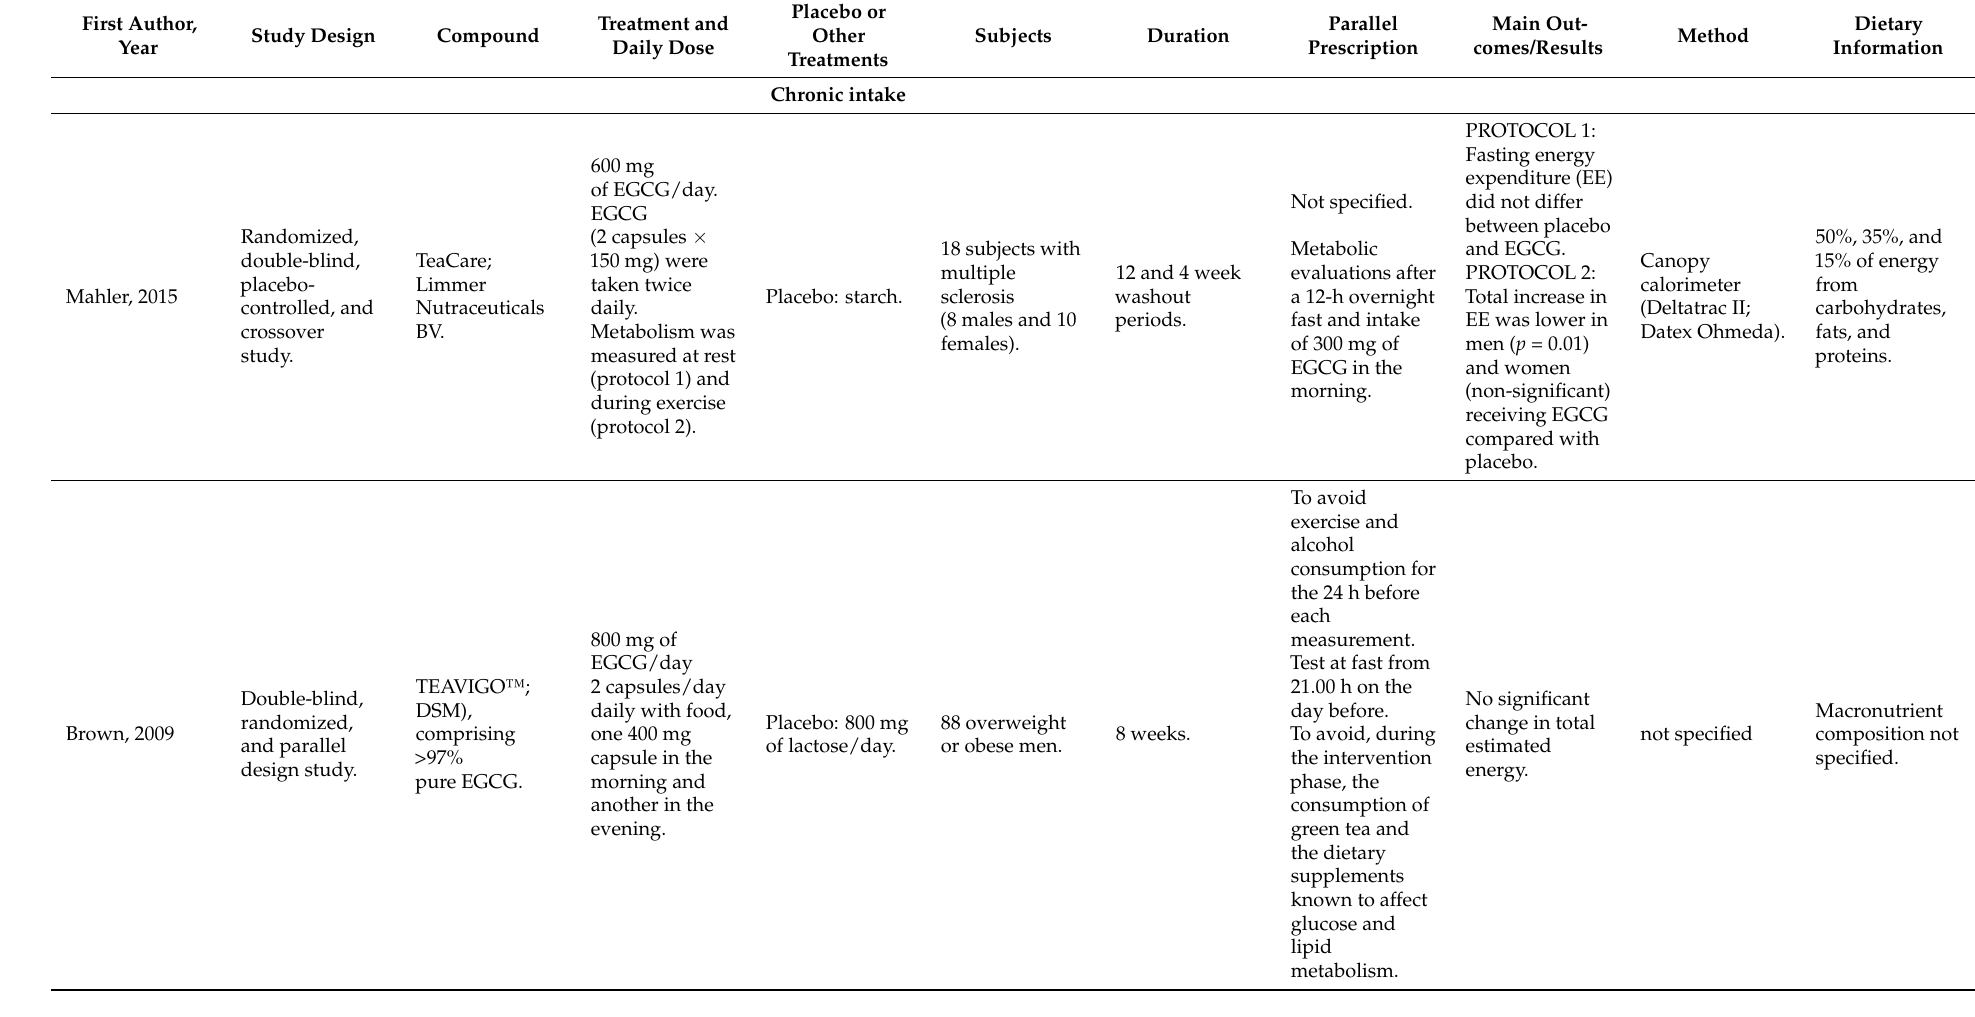
Table 2. Studies on the effects of GTC supplementation on total energy